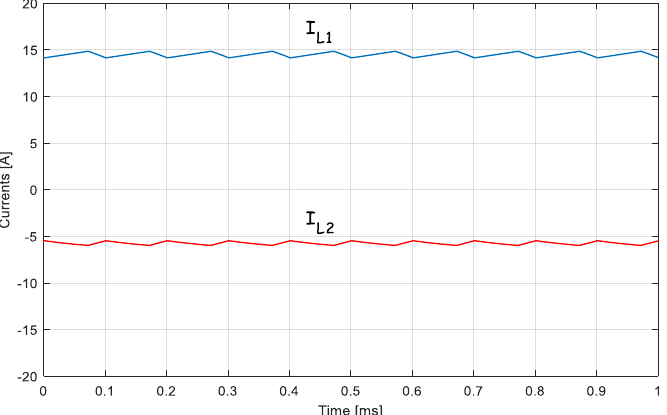
Figure 10. Simulation results of the L 1 and L 2 inductor currents in boost mode.